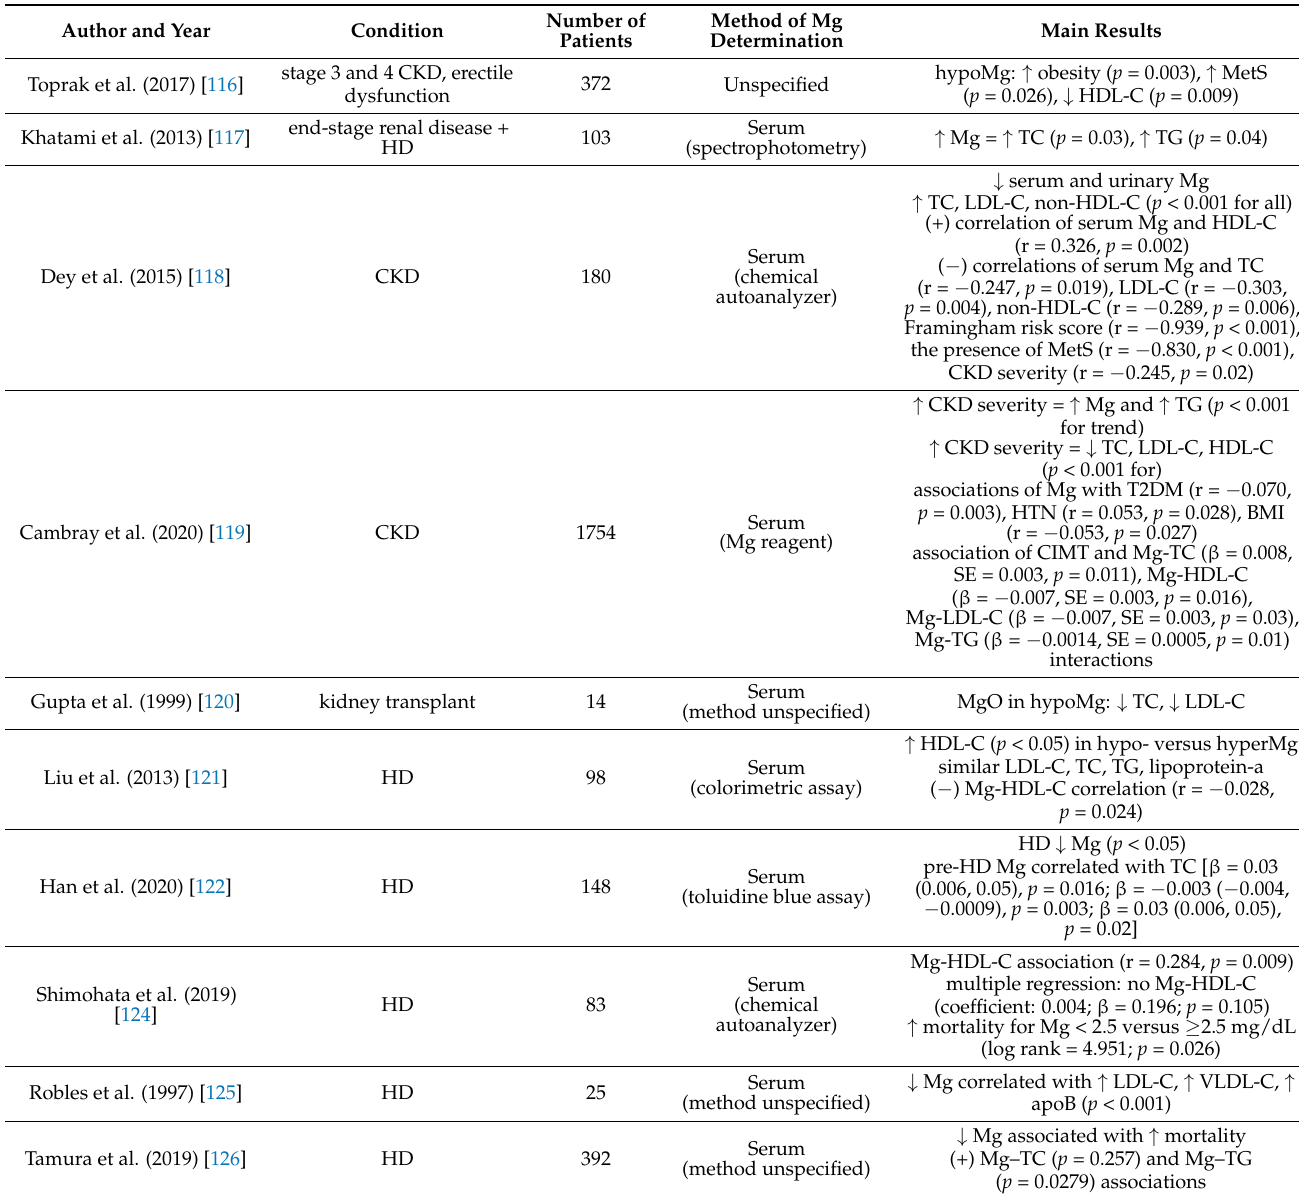
Table 6. Interplay of magnesium, serum lipids, and the